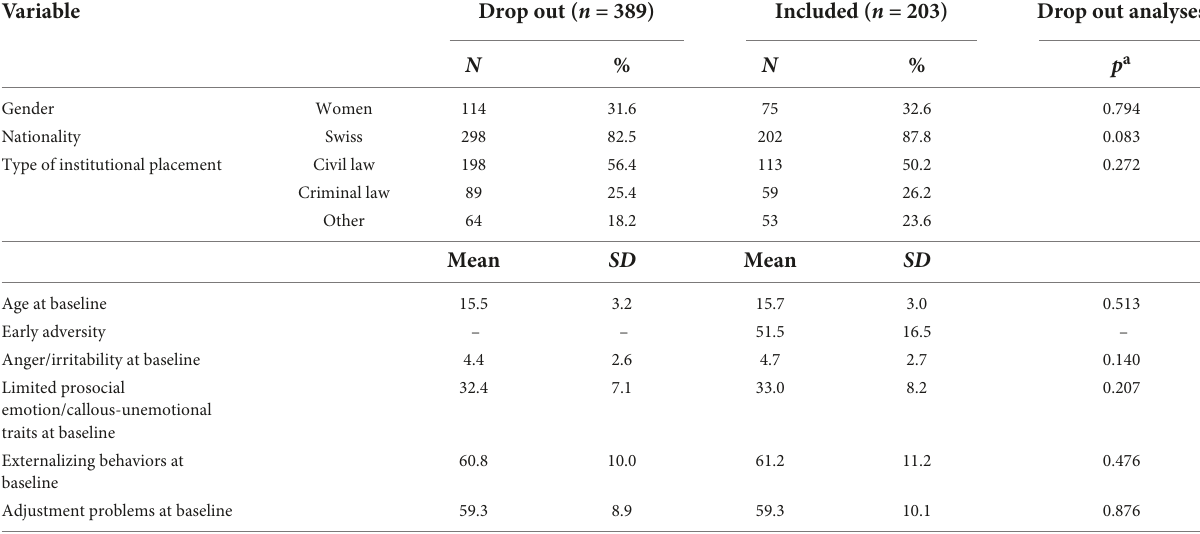
TABLE 2 Descriptive and drop-out analyses. Variable